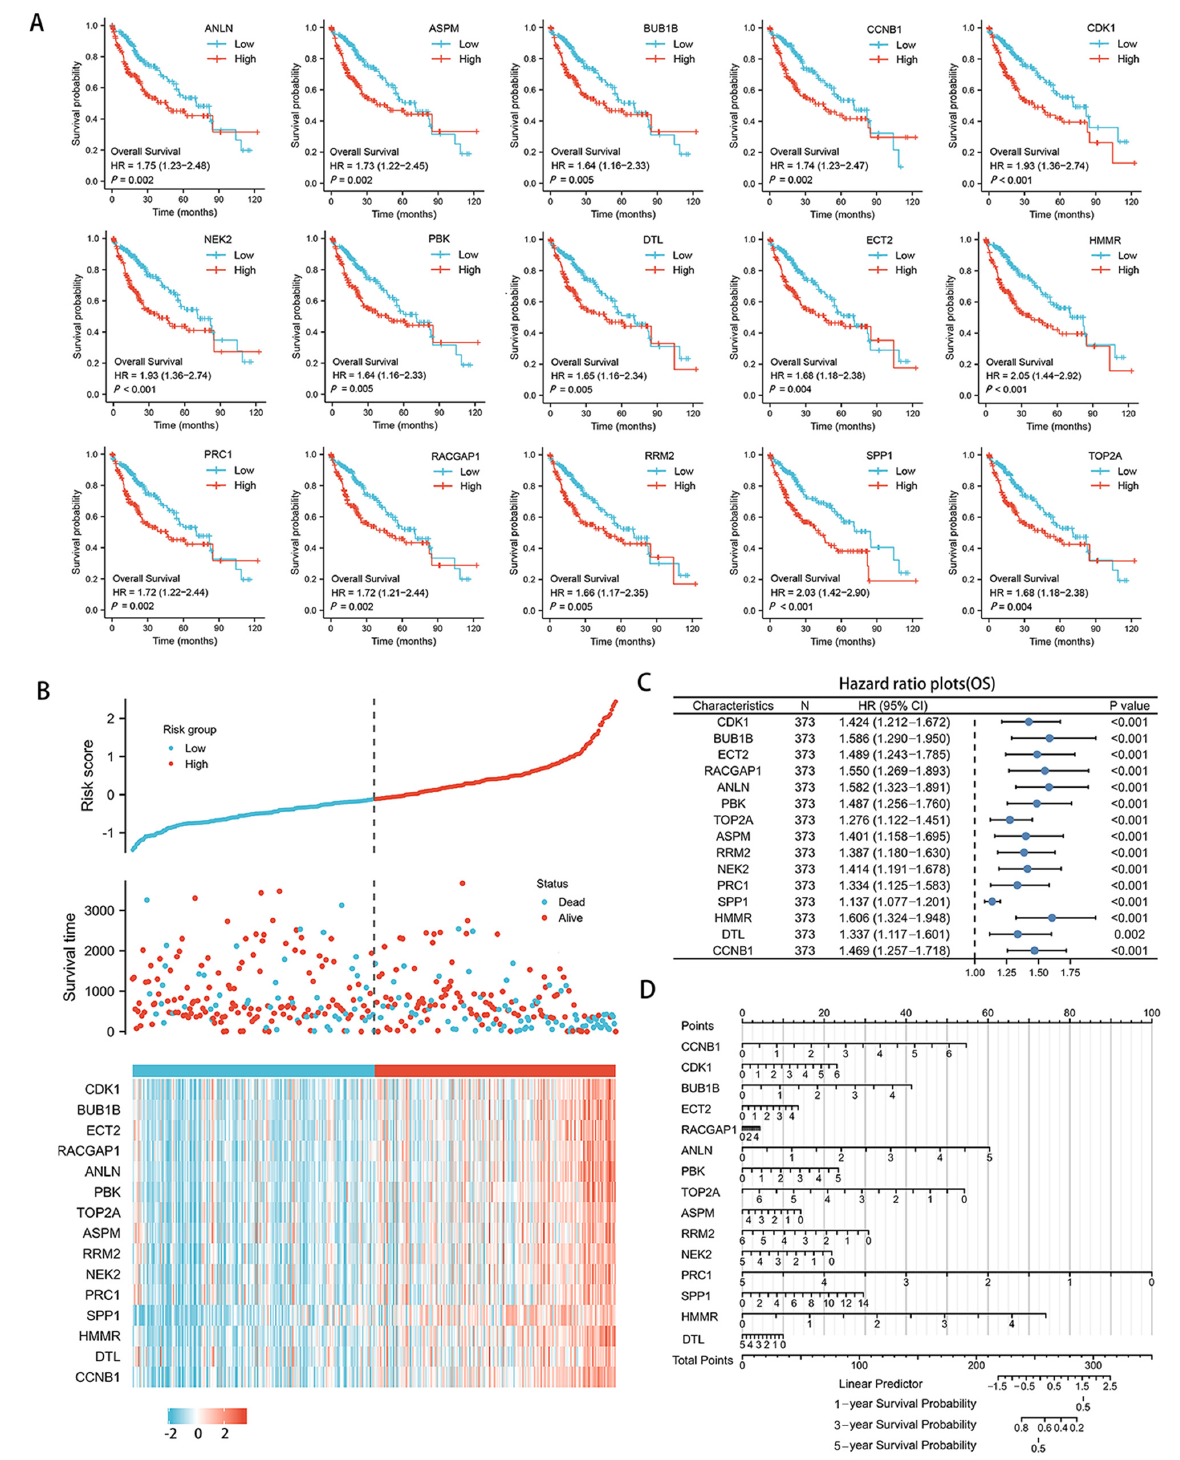
Figure 7. Multifaceted clinical value analysis of up-regulated hub genes in HCC. ( A ) Kaplan-Meier plot of OS between high-expression and low-expression groups. The red lines and blue lines, respectively, represent patients with high gene and low gene expression. ( B ) Risk score in the cohort of TCGA. The distribution of patients with an increased risk score into high- and low-risk groups, as well as scatter plots depicting patient survival with an increased risk score. ( C ) Forest plot showing OS after univariate Cox regression analysis in HCC. ( D ) Nomogram for predicting the probability of 1-, 3-, and 5-year OS for patients with HCC. OS, overall